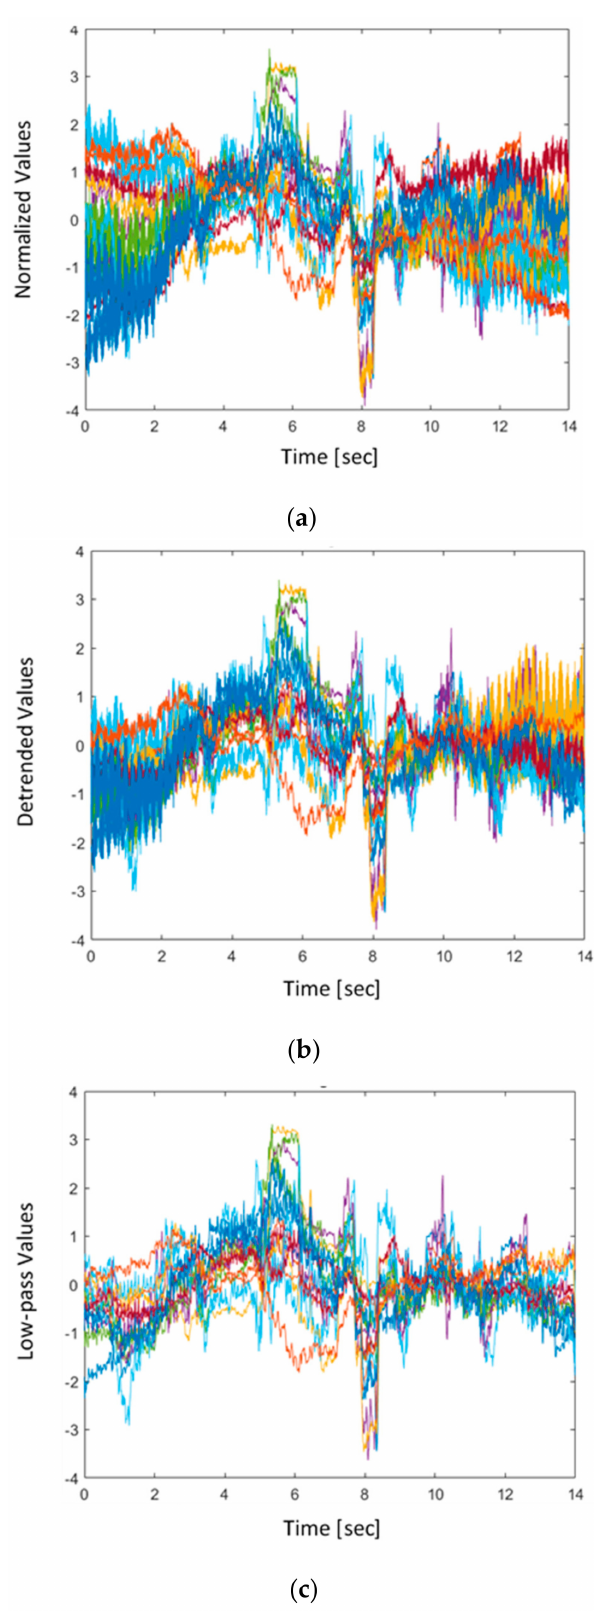
Figure 14. ( a ) Normalized channels using the z-score method; ( b ) detrended signal by removing the mean; and ( c ) low-passed signals at 60